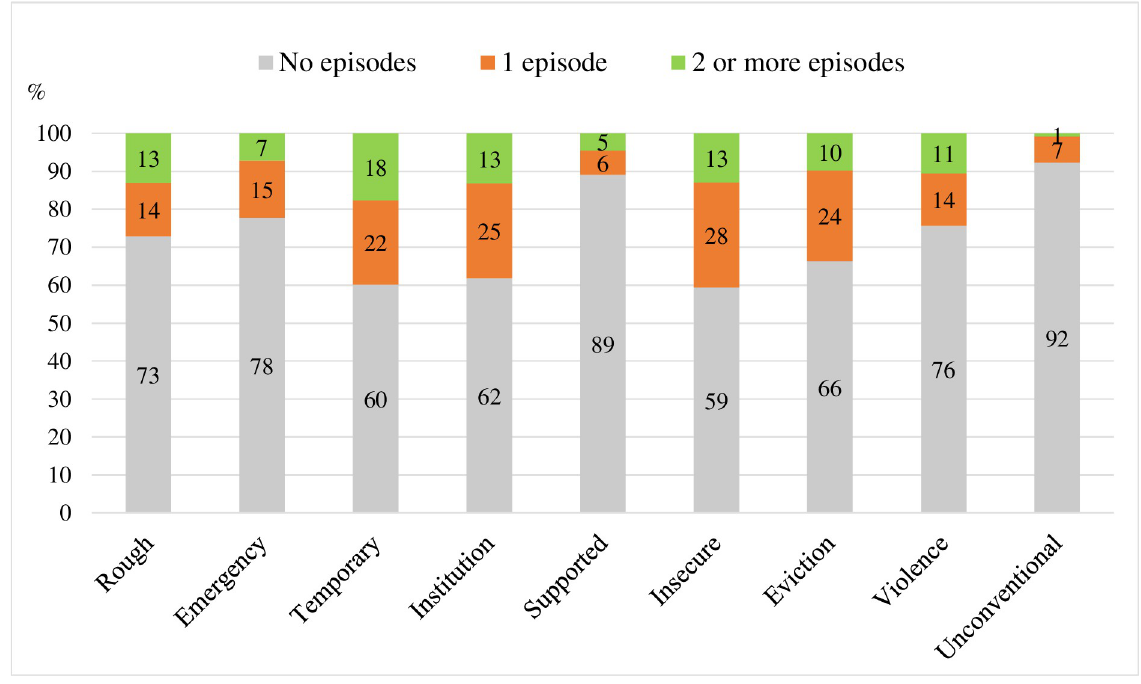
Fig 2. Proportion of homeless young people who experienced various forms of homelessness types (2013–2018).